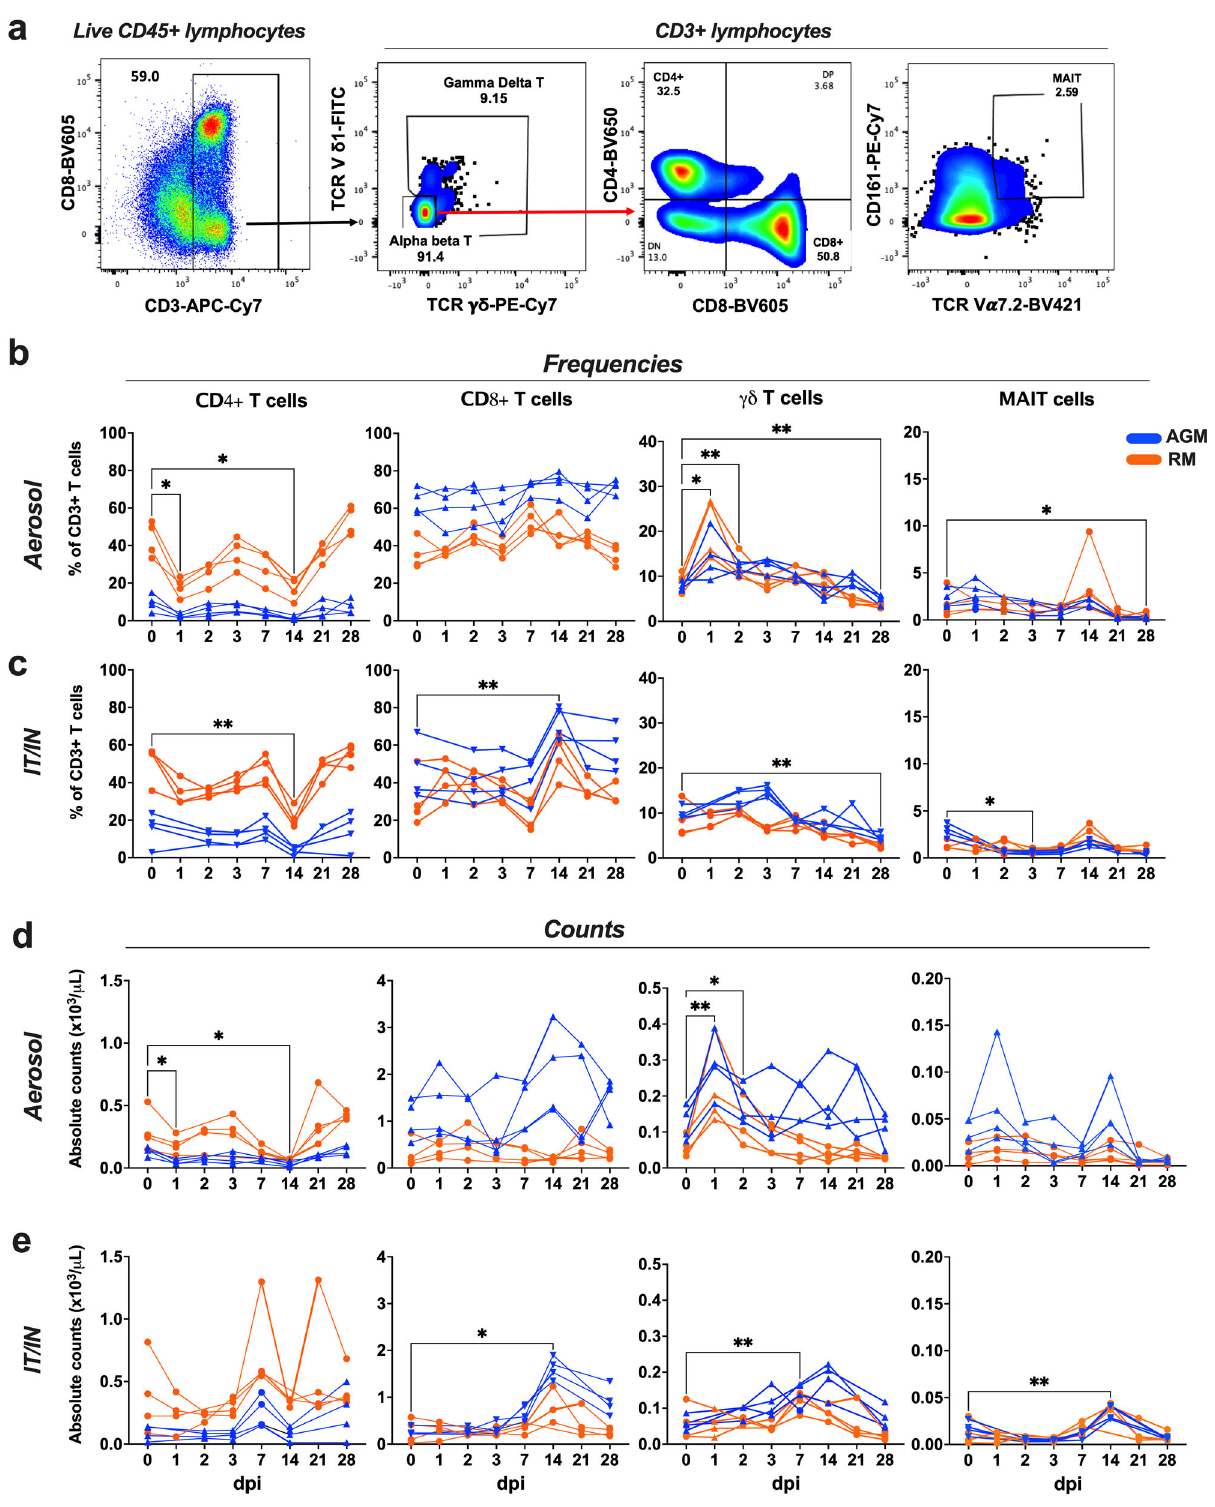
Fig. 2 Dynamics of circulating adaptive and innate T lymphocyte subsets during SARS-CoV-2 infection via aerosol and IT/IN route in NHPs. a Representative FACS plots of PBMC showing gating strategy for γδ T, CD4 T, CD8 T and MAIT cells. Quanti fi cation of T cell subset frequencies in peripheral blood as percentage of CD3 + T cells following SARS-CoV-2 infection in 8 animals per group either via aerosol ( b ) or IT/IN route (c ) on 0, 1, 2, 3, 7, 14, 21, and 28 dpi. Absolute counts per μ L of blood for γδ T, CD4 T, CD8 T and MAIT cells in aerosol ( d ) and IT/IN ( e ) route of infection. Individual values shown for each animal as symbols connected by lines for RMs (orange) and AGMs (blue). Comparisons of different time points with respect to d0 baseline data were done using repeated measures one-way ANOVA with Dunnett ’ s post hoc tests. Asterisks indicate signi fi cant differences between time points (* p < 0.05; ** p <